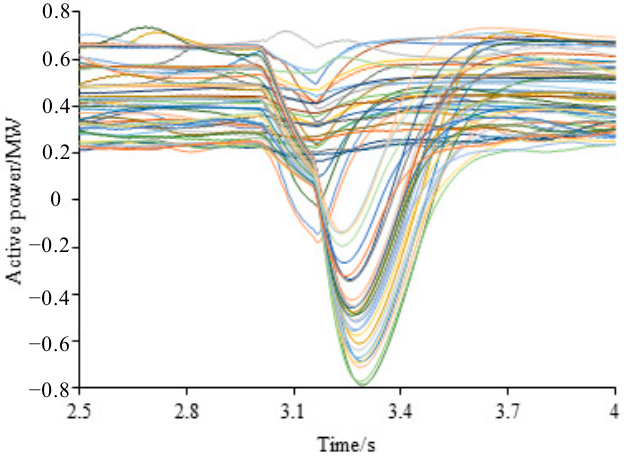
Figure 7. Active power of W1 under different random combination.